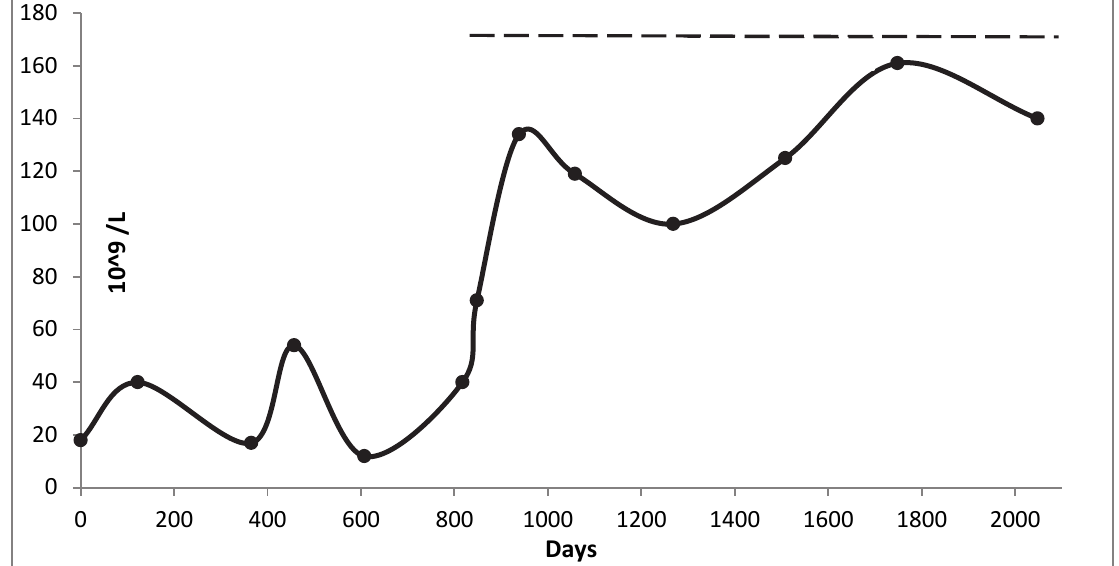
Figure 1. Platelet count during follow-up.